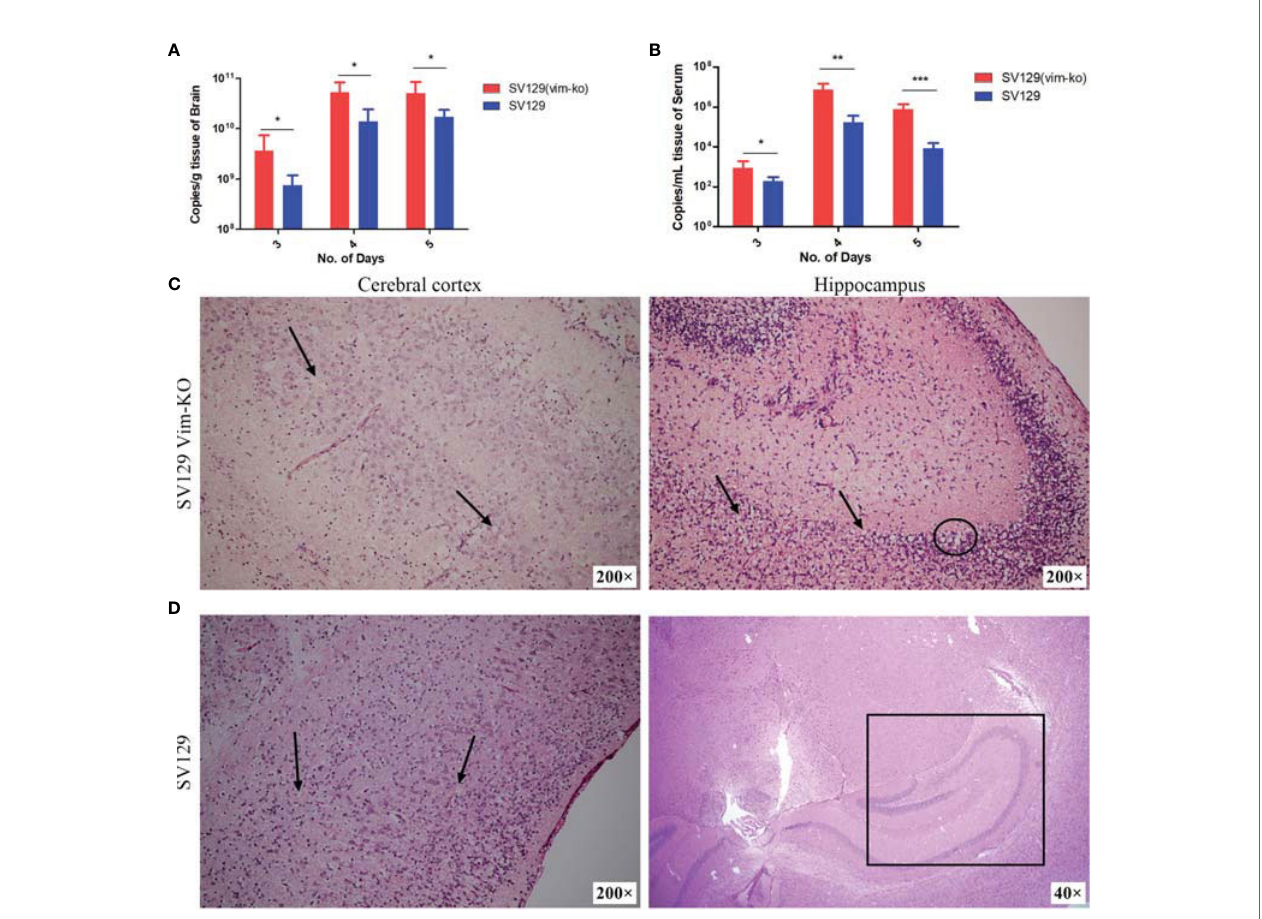
FIGURE 5 | Detection of viral load in serum and brain and description of brain histopathological damage after infection of SV129 and SV129 (Vim-KO) mice with dengue virus (DENV)-2. (A, B) Changes in the viral load in the brain and serum; *P < 0.05; **P < 0.01; ***P < 0.001. (C, D) Brain histopathological section on the 5th day after infection in SV129 and SV129 (Vim-KO) mice. (C) Left: the cortical strati fi cations disappeared, with a large number of apoptotic pyknotic cells (black arrow). Right: the hippocampus displayed apoptotic pyknosis of glial cells (black arrow) and local cerebral liquefactive necrosis (black circled). (D) Left: the cortical strati fi cation was normal, and apoptotic pyknosis of glial cells (black arrow) was found in all six cortical layers. Right: the hippocampus (black square) showed no obvious